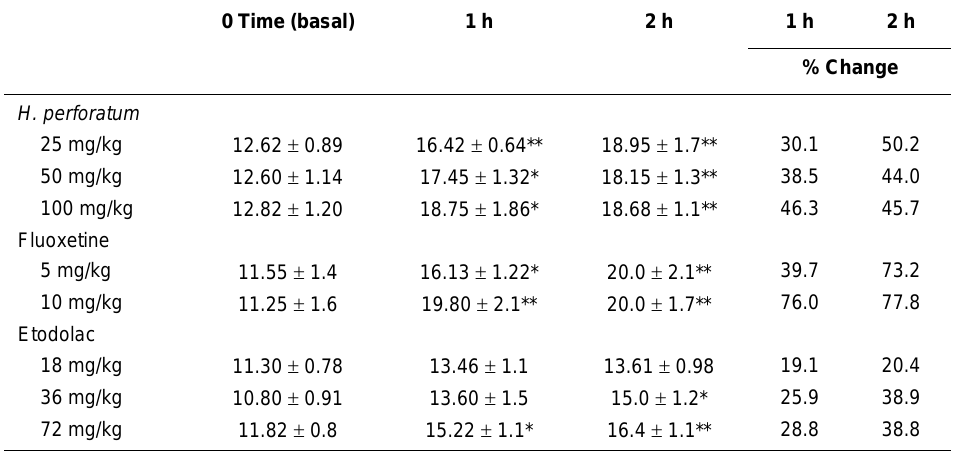
Antinociceptive Activity of H. perforatum , Fluoxetine, and Etodolac in the Hot Plate Test 0 Time (basal)